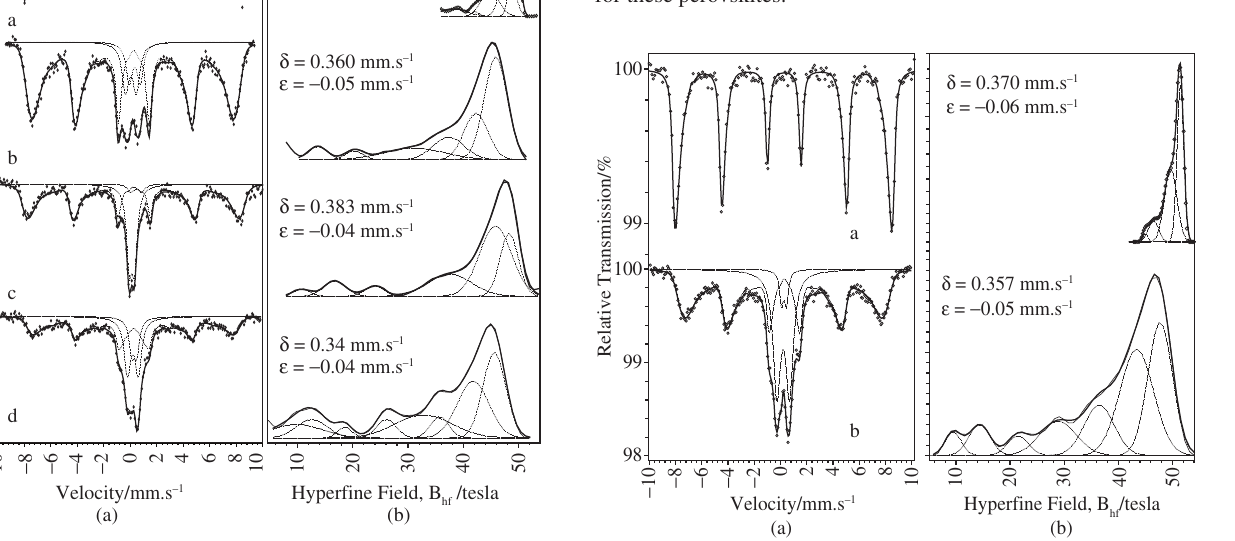
Figure 5. Mössbauer spectra of the LaFe the 25 wt (%) supported on Al (right